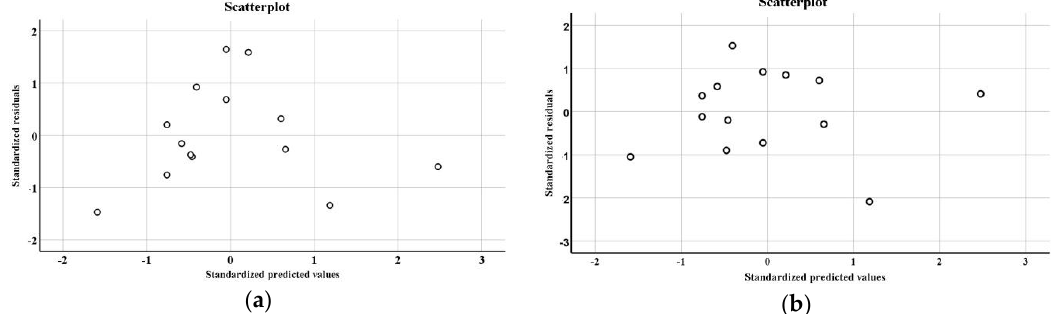
Figure 11. Scatter plot of the standardized predicted values vs. standardized residuals. ( a ) Model of Equation (1); ( b ) Model of Equation (2).